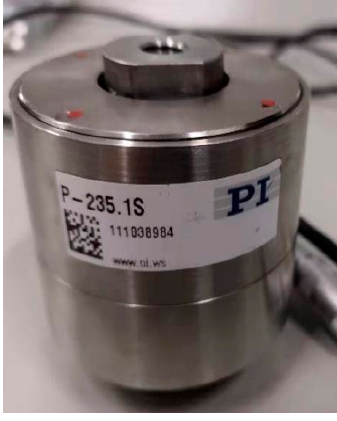
Figure 7. The P-235.1s PZT.